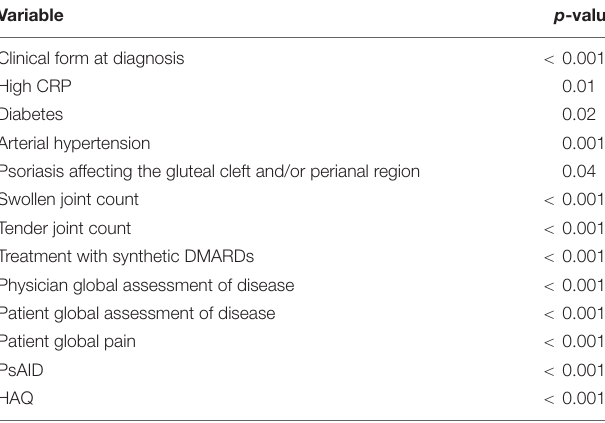
TABLE 2 | Variables associated with severe disease. Bivariate